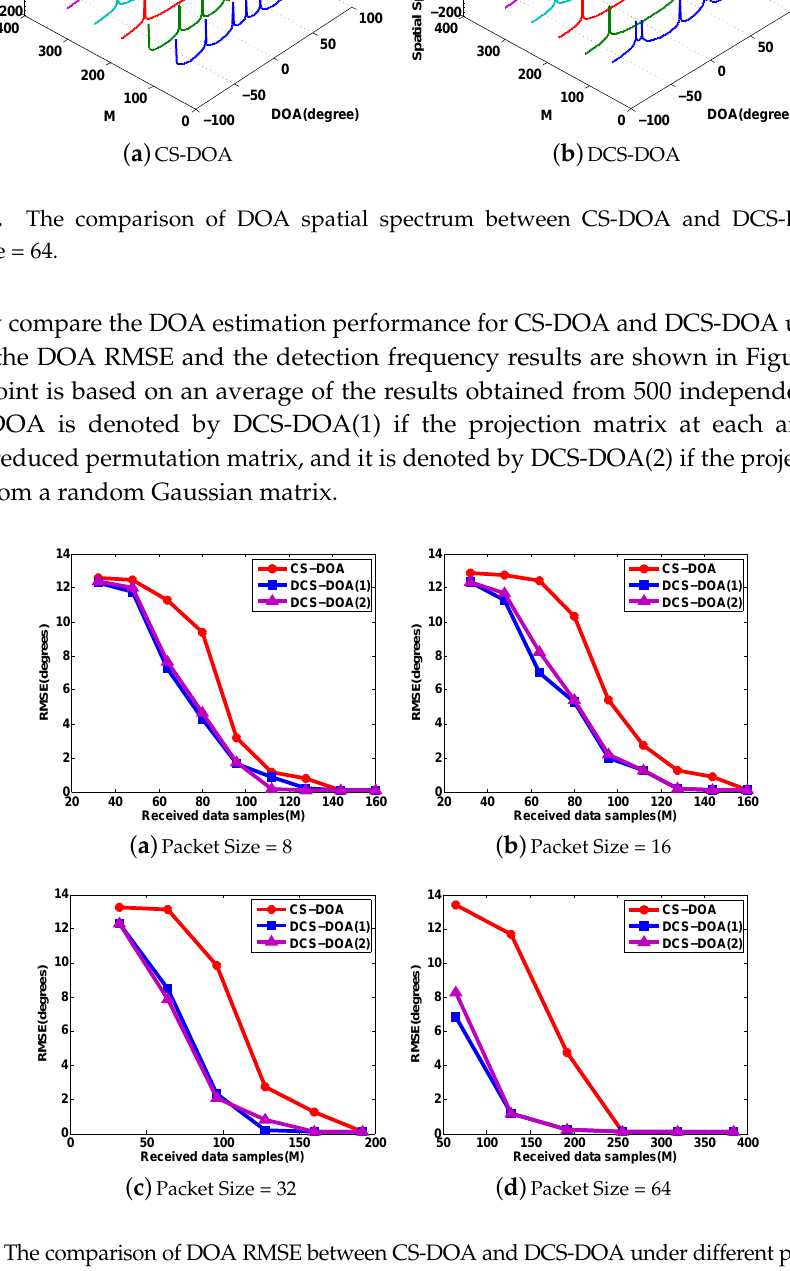
Figure 12. The comparison of DOA RMSE between CS-DOA and DCS-DOA under different packet